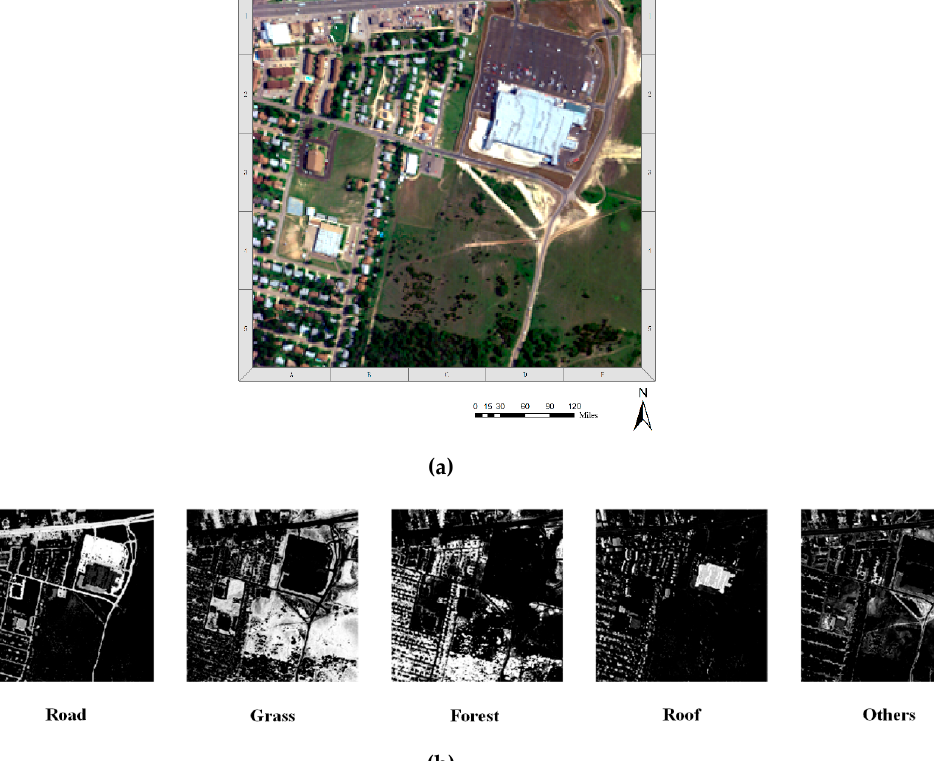
Figure 3. Two remote sensing images in the study region: ( a ) remote sensing image of the study region with 2-m spatial resolution, and ( b ) five categories of ground objects in the same region with 2-m spatial resolution.